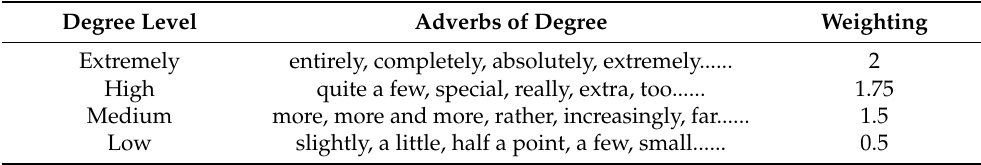
Table 1. Adverb dictionary. Degree